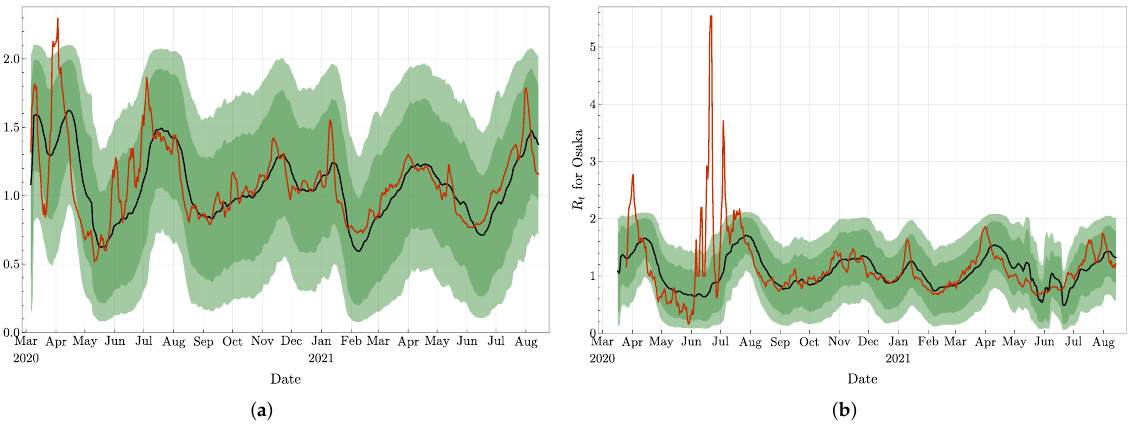
Figure 13. The effective reproduction number for Japan ( a ) and for Osaka ( b ): The black curve and the green confidence intervals are from our approach, and the red curve is borrowed from